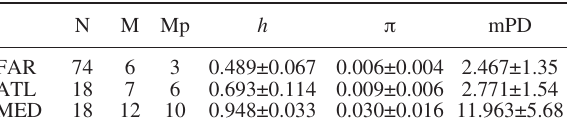
Table 3. – Genetic variability estimators from the analysis of 412 bp of the mtDNA Control Region-I sequences for three samples of Senegalese